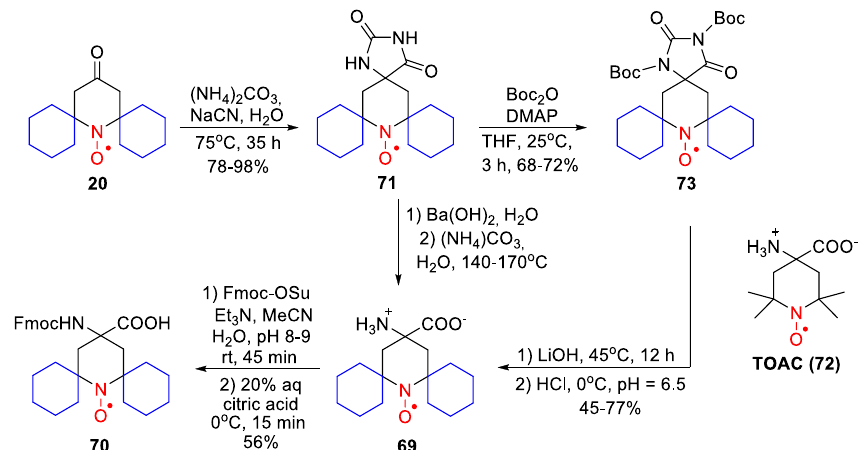
Scheme 12. Synthesis of amino acid derivatives of SNRs of the TEMPO type.